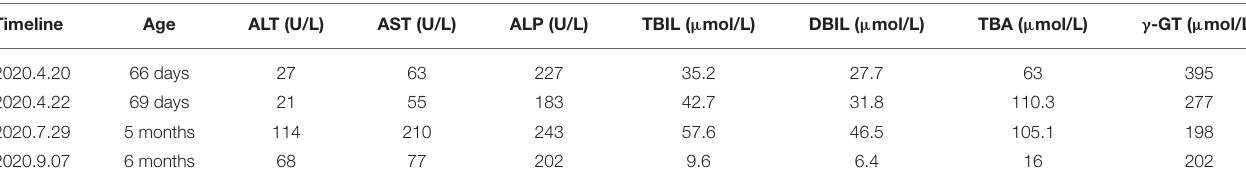
TABLE 1 | Results of liver function in children at various